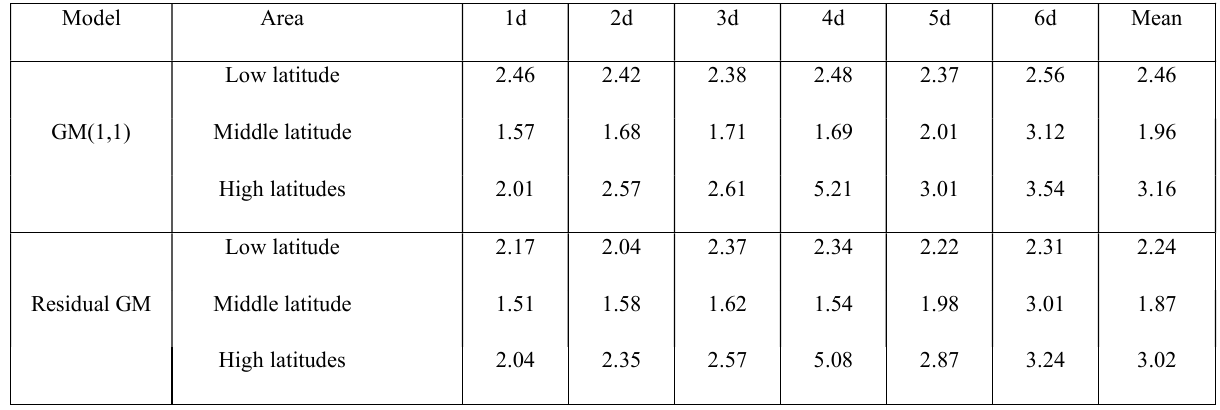
Table. 6 RMSE statistics of mean-variance in autumn forecast